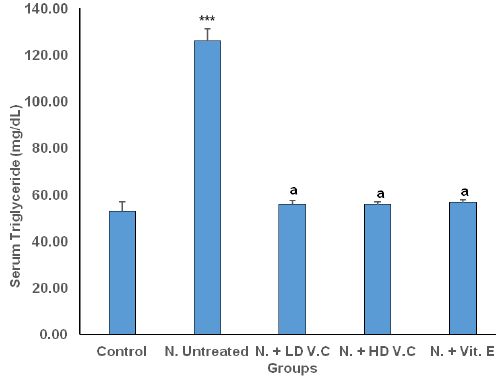
Figure 2. Effect of V. calvoana extract on serum triacylglycerol in paracetamol treated rats. Values are presented as mean ± SEM, n = 5. *** p <0.001 vs. control, a = p <0.001 vs. N. untreated. Where N = hepatotoxic.